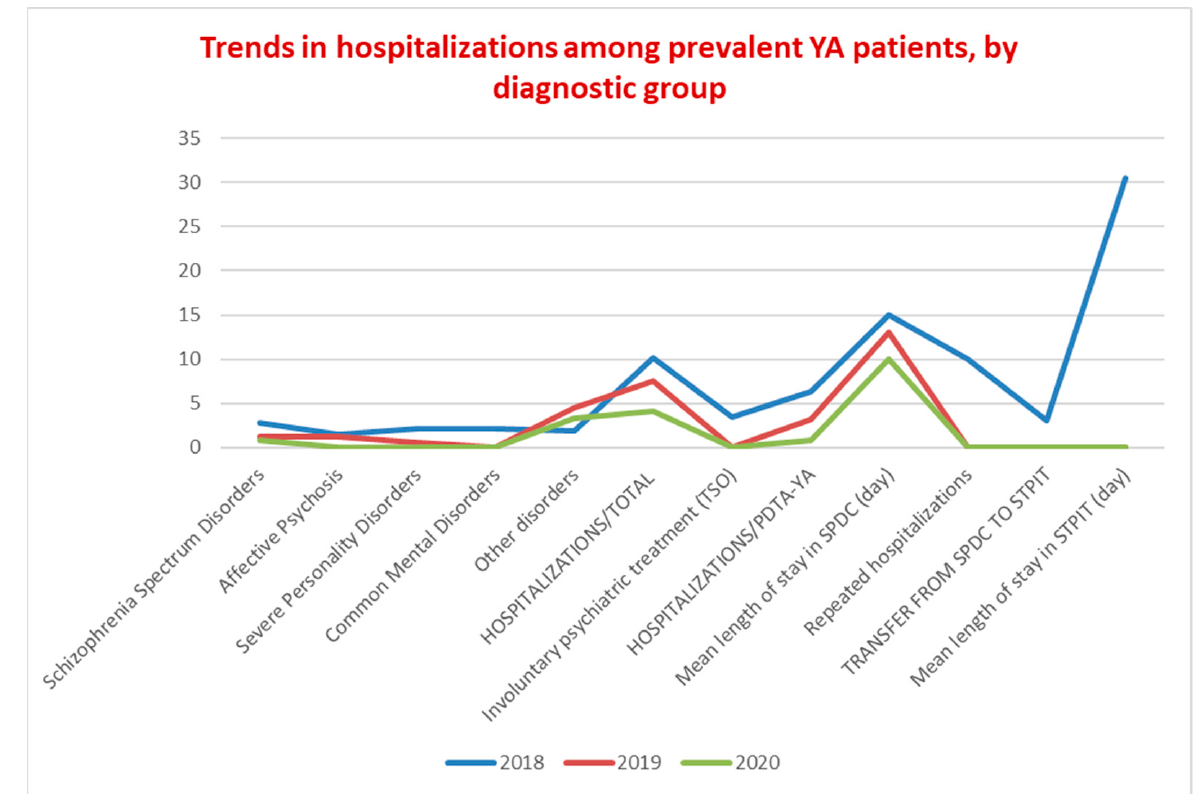
Figure 4. Trends in hospitalizations among prevalent YA patients, by diagnostic group.